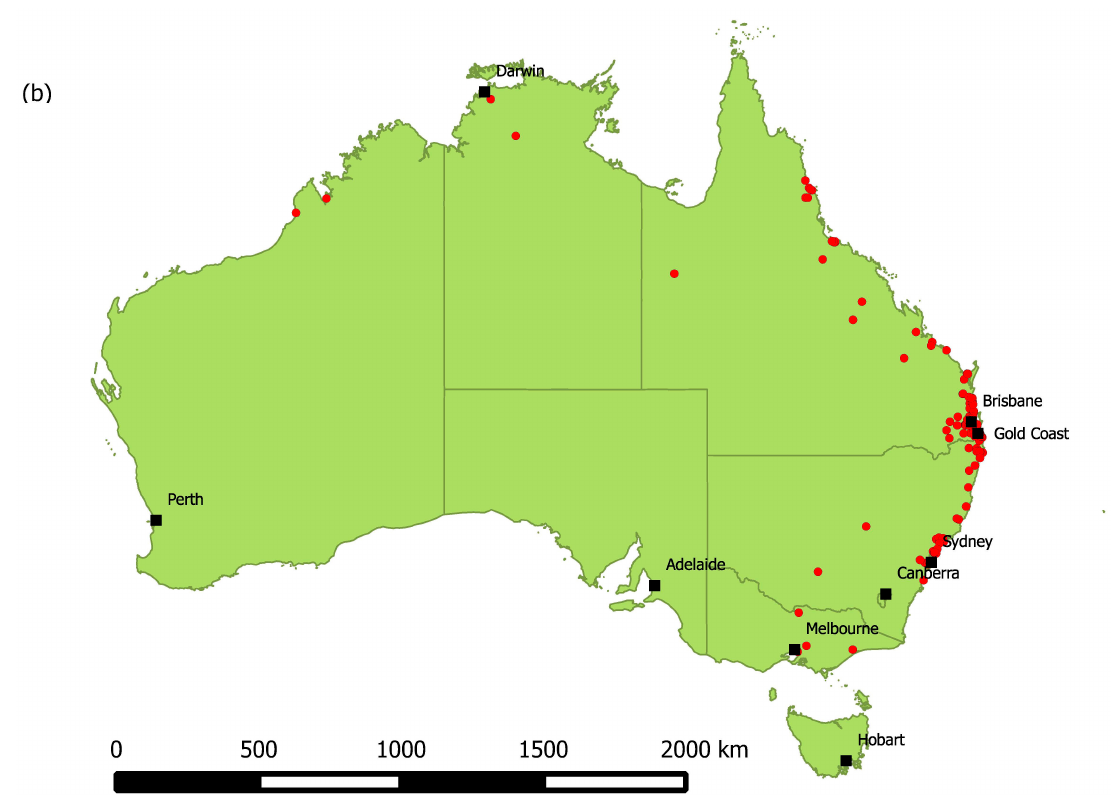
Figure 1. ( a ) Number of ABLV test positive bats per year, 1995–2016. ( b ) Locations from which ABLV test positive bats were submitted, 1995–2016. Red points represent locations at which test positive bats were found. Relevant cities and population centres are marked with a black